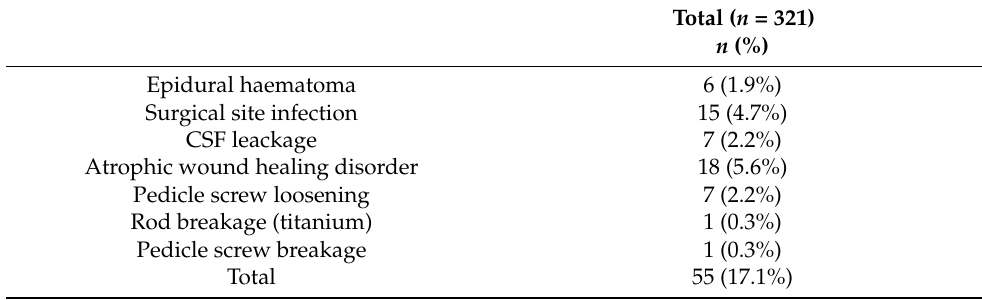
Table 5. Postoperative complications requiring revision surgery. CSF = cerebrospinal fluid; n = number.